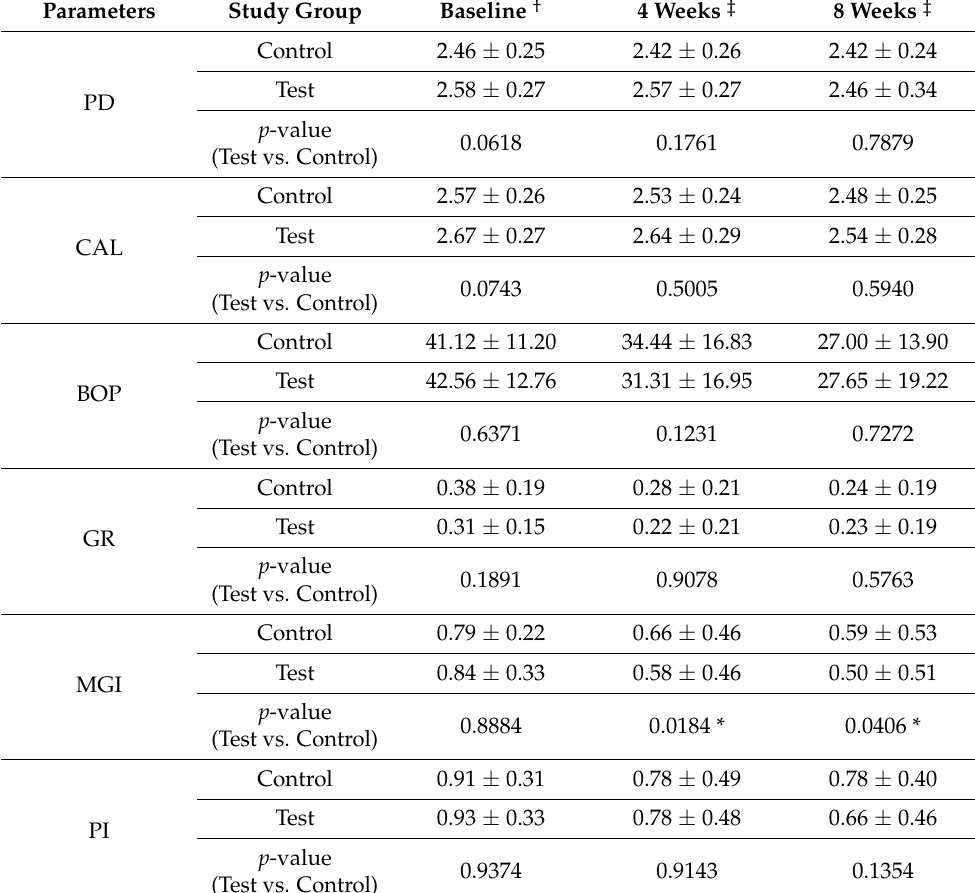
Table 3. Clinical parameters of test and control group (mean ±